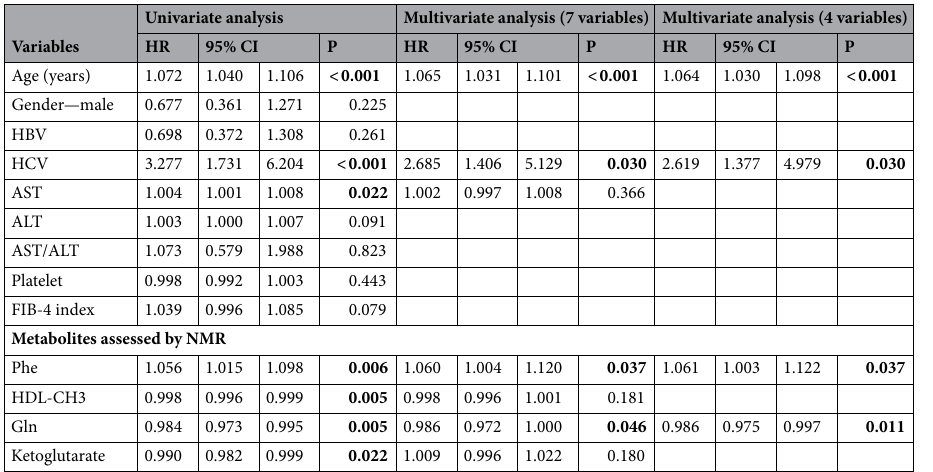
Table 2. Clinical variables and metabolites in association with the time to HCC occurrence. P values less than 0.05 are indicated in bold. HBV, hepatitis B virus; HCV, hepatitis C virus; AST, aspartate transaminase;